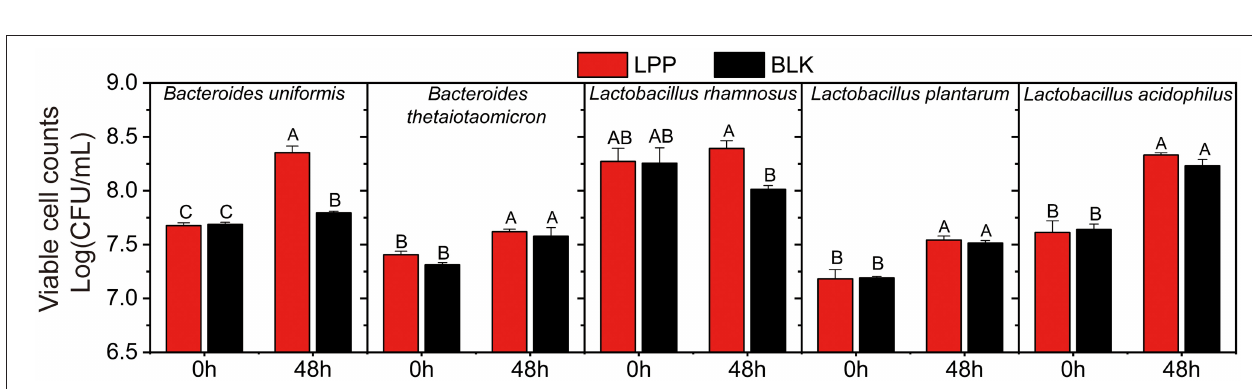
The absorbance of reactant was then measured at 734 nm.